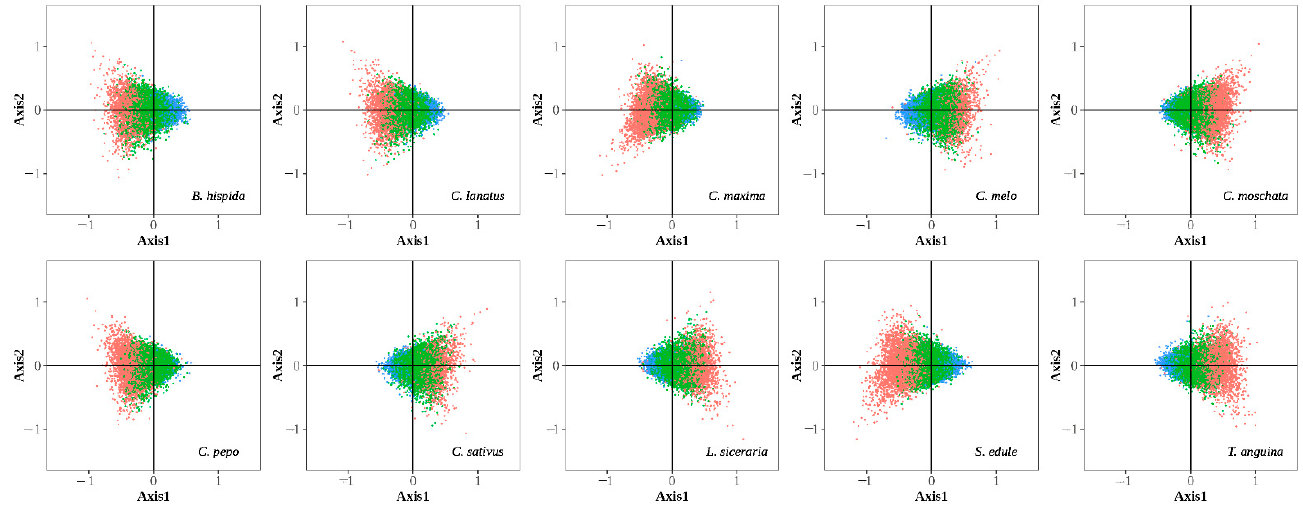
Figure 3. Correspondence analysis of CUB of ten species of Cucurbitaceae: the distribution of genes is shown along the first and second axes. Note: The red, green, and blue dots represent the genes with GC content higher than 60%, within 45–60%, and lower than 45%.